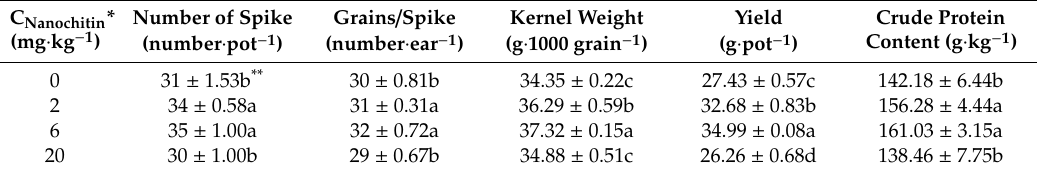
Table 1. E ff ects of nanochitin on grain yield and crude protein concentration of winter Table 1. Effects of nanochitin on grain yield and crude protein concentration of winter wheat.